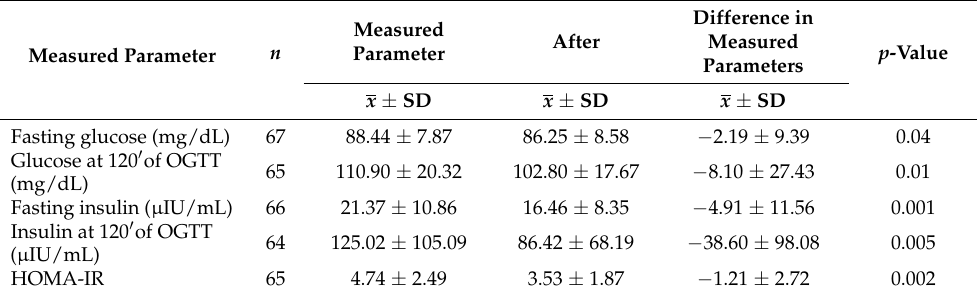
Table 4. Measured glucose metabolism parameters before and after the dietary intervention.